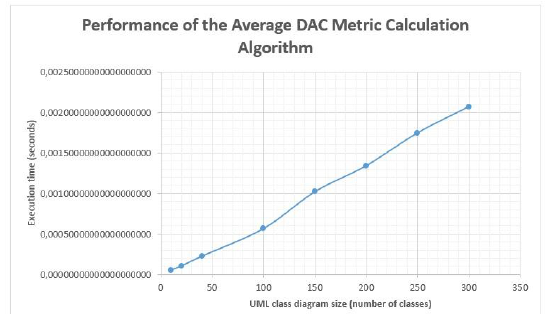
Fig. 7. The value of the execution time was calculated as the average execution time measured during 10000 runs for each UML class diagram size.